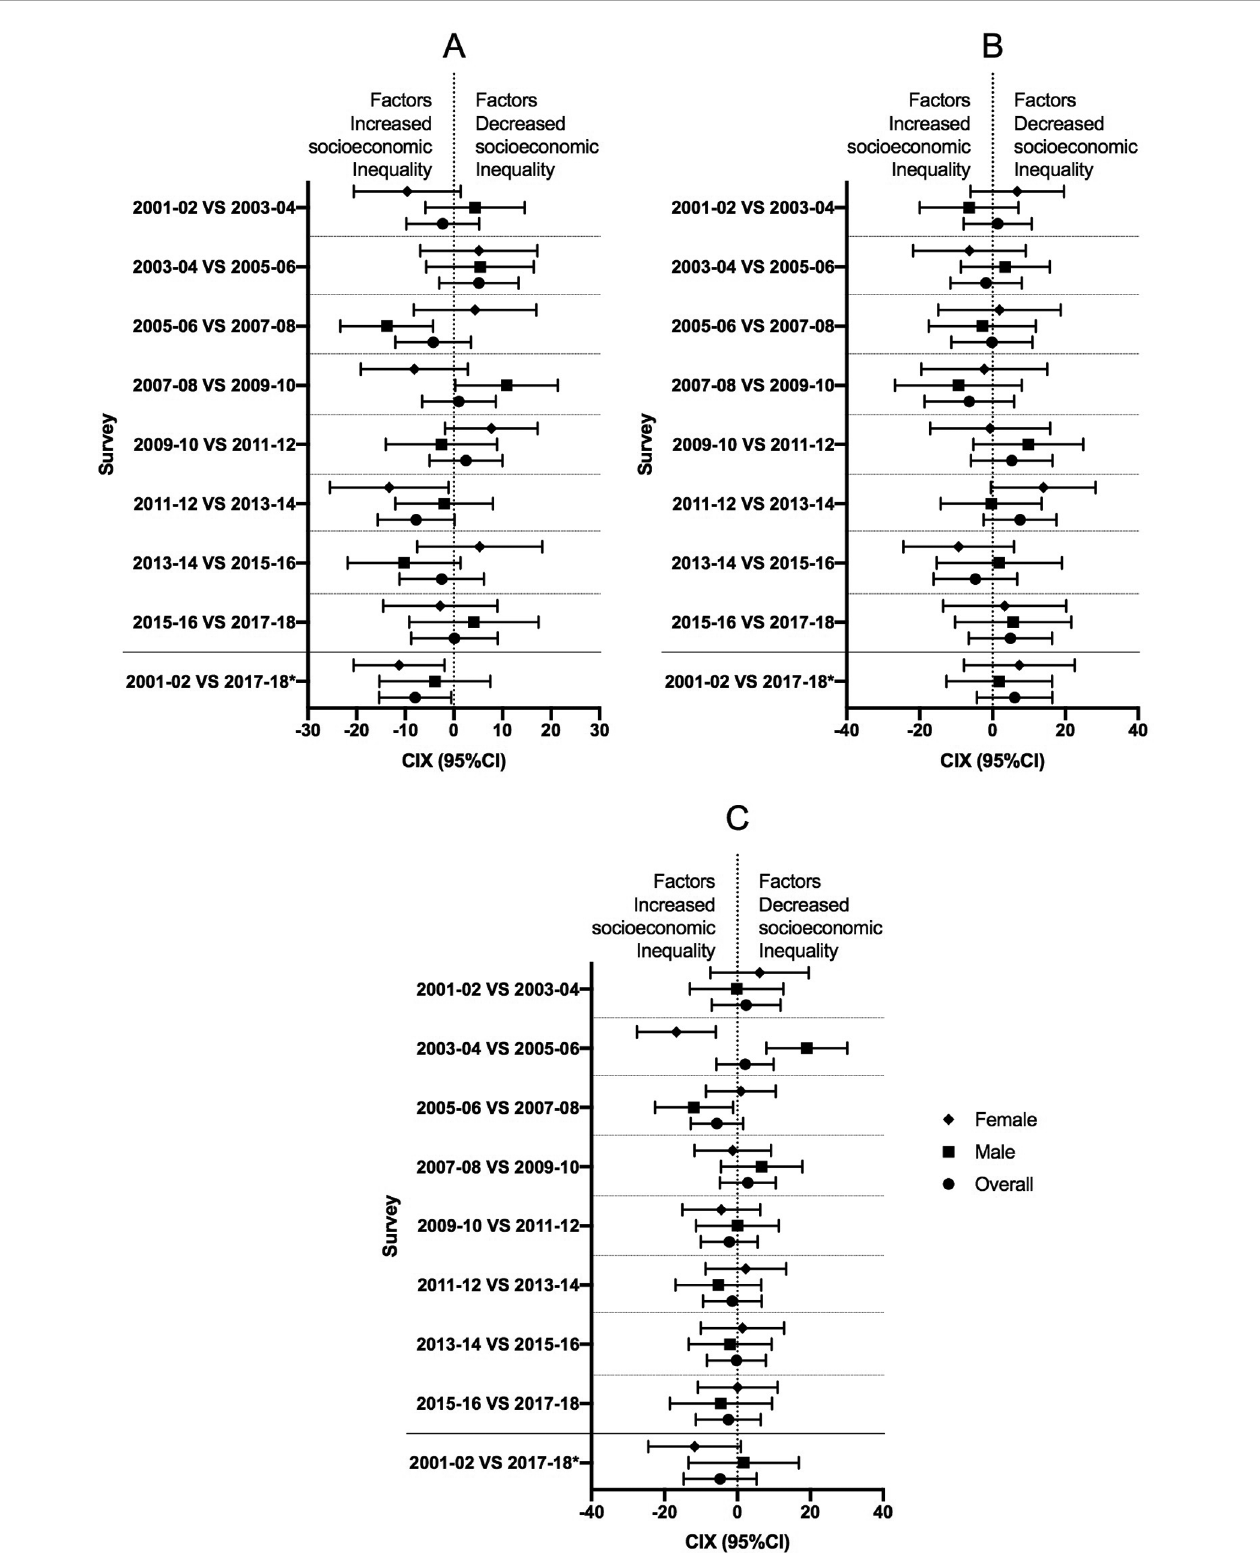
FIGURE 4 Annualized changes of relative wealth inequality in the overweight/obesity prevalence among children by sex. CIX: concentration Index. A: Caucasian, B: African American, C: Other ethnicities , CI: con fi dence interval. *: comparison of inequality between 2001 – 02 and 2017 – 18.